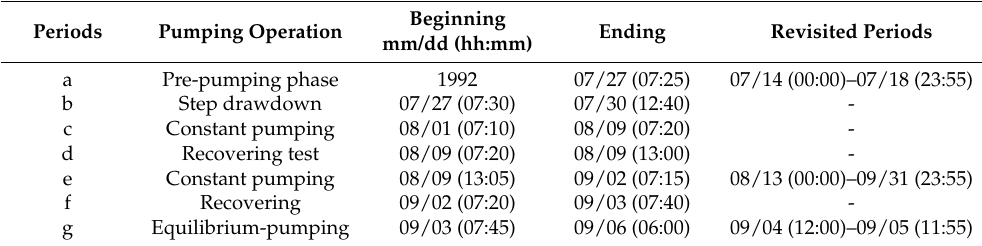
Table 1. Chronology of pumping test phases and